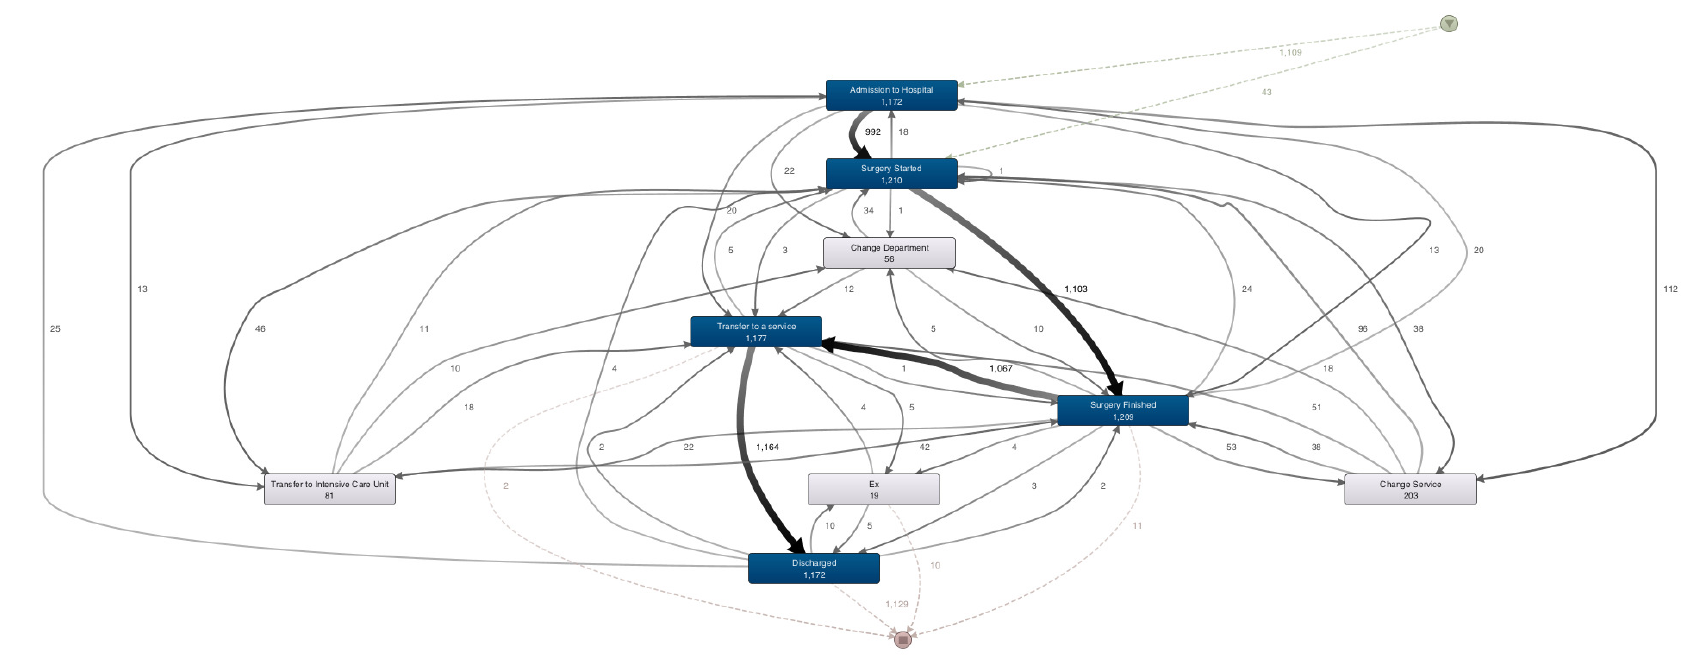
Figure 3. Complete Process Map of Surgery